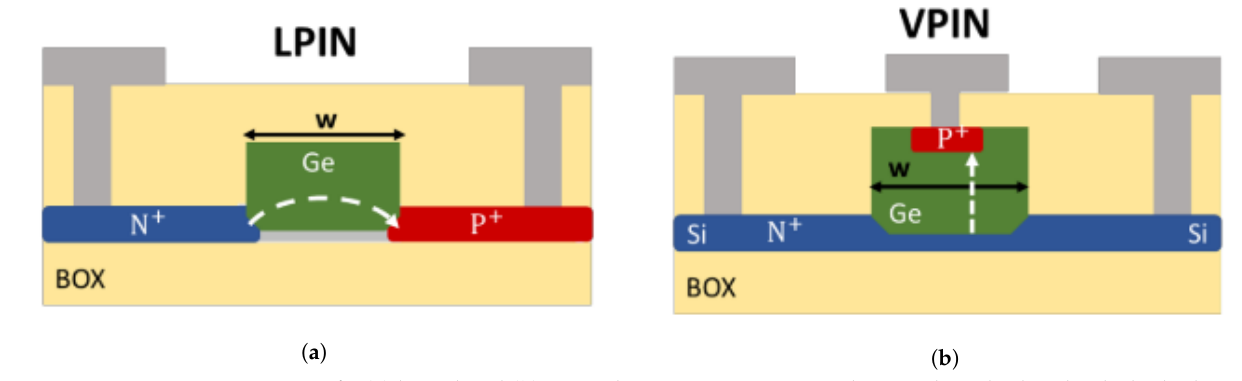
Figure 7. Cross-section view of a ( a ) lateral and ( b ) vertical germanium-integrated, p-i-n photodiode. The dashed white arrow shows the electric field shape and direction (after [66]).